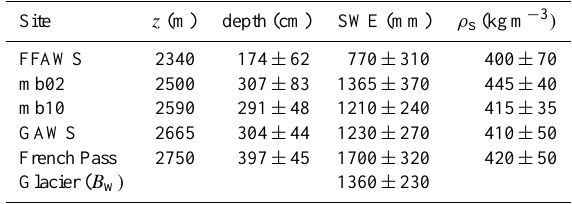
Table 3. Mean value ± one standard deviation of May snowpack data based on snow pit measurements from sites at Haig Glacier, 2002–2013. Glacier-wide winter mass balance, B w , is also reported. See Fig. 1 for snow sampling